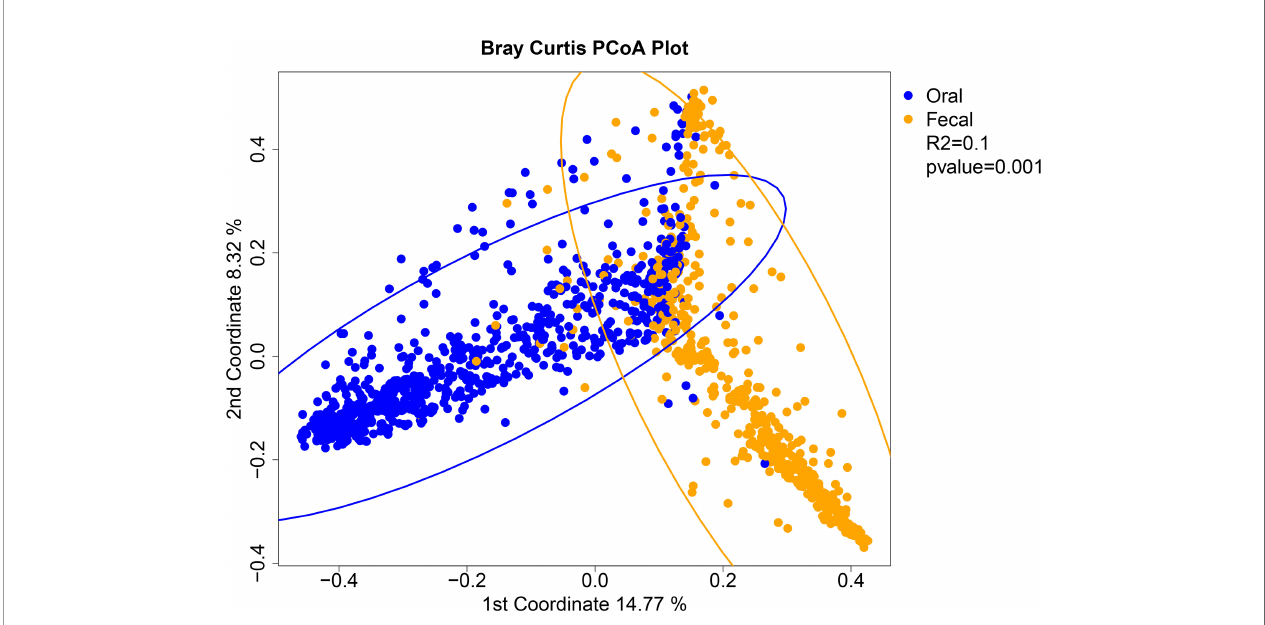
FIGURE 1 | Analysis of beta-diversity demonstrates coalescence between oral and stool communities among leukemia patients undergoing induction chemotherapy. Principal coordinates analysis plot of the Bray-Curtis dissimilarity with 95% con fi dence ellipses of the 737 oral samples and 551 fecal samples separately. Oral (blue) and stool (orange) samples are colored by sample site. The P-value and coef fi cient of determination are derived from permutation based multivariate analysis of variance (PERMANOVA) using the Bray-Curtis dissimilarity matrix for all